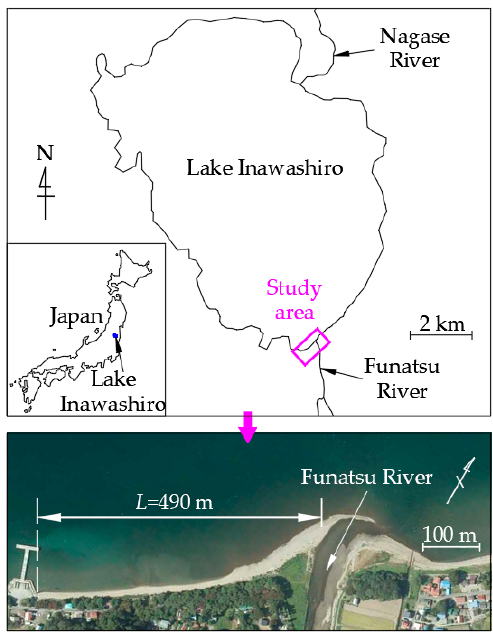
Figure 12. Funatsu River delta in Lake Inawashiro, Japan.